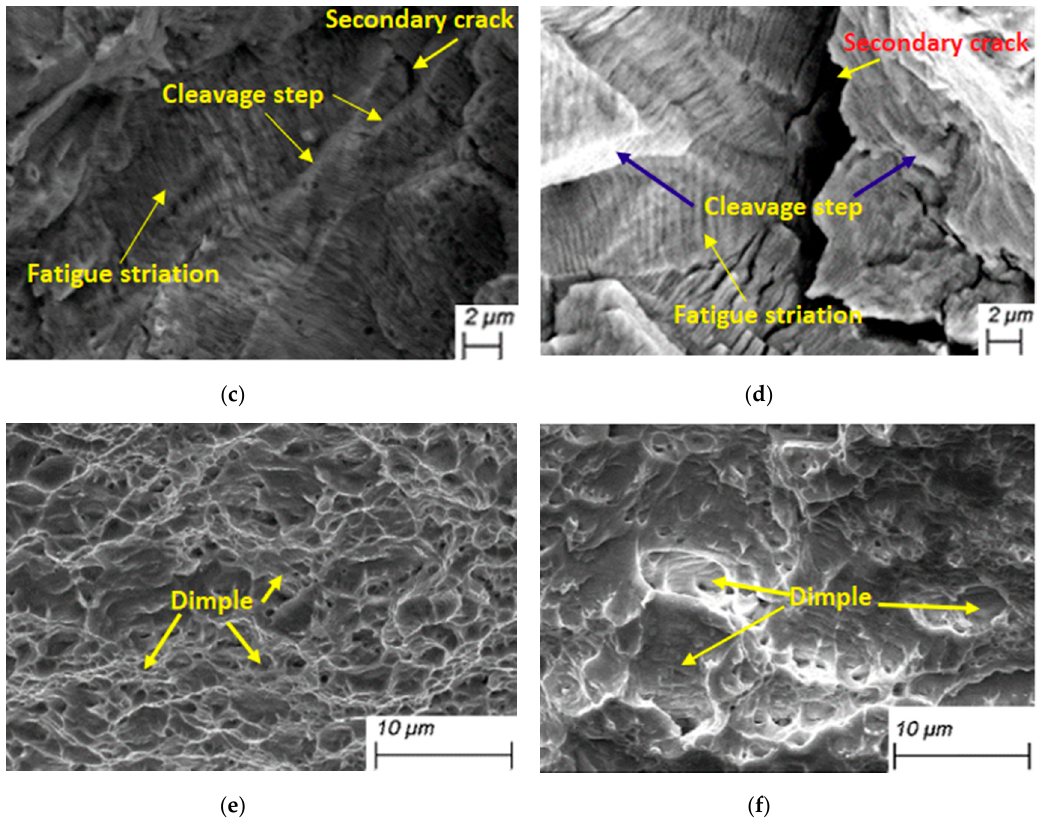
Figure 11. Fracture morphologies of GH3039 superalloy before and after LSP: Macroscopic fracture morphologies before ( a ) and after LSP ( b ); Fatigue crack growth area morphologies before ( c ) and after LSP ( d ); Transient fracture area morphologies before ( e ) and after LSP ( f ).